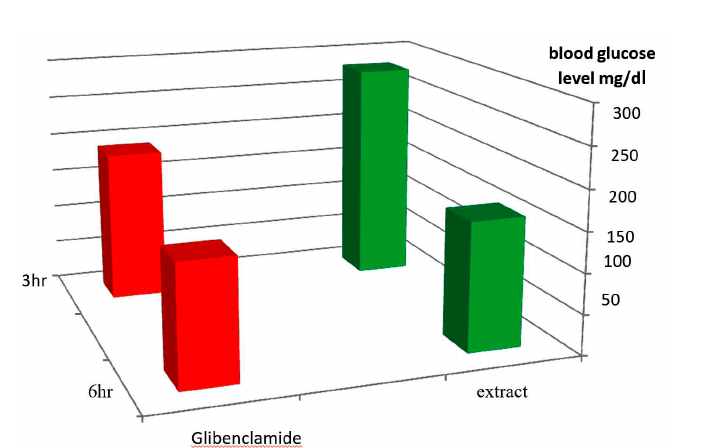
Fig. 6. comparison the effect of the extract and glibenclamide drug in blood glucose level after (3,6) hr in laboratory rats